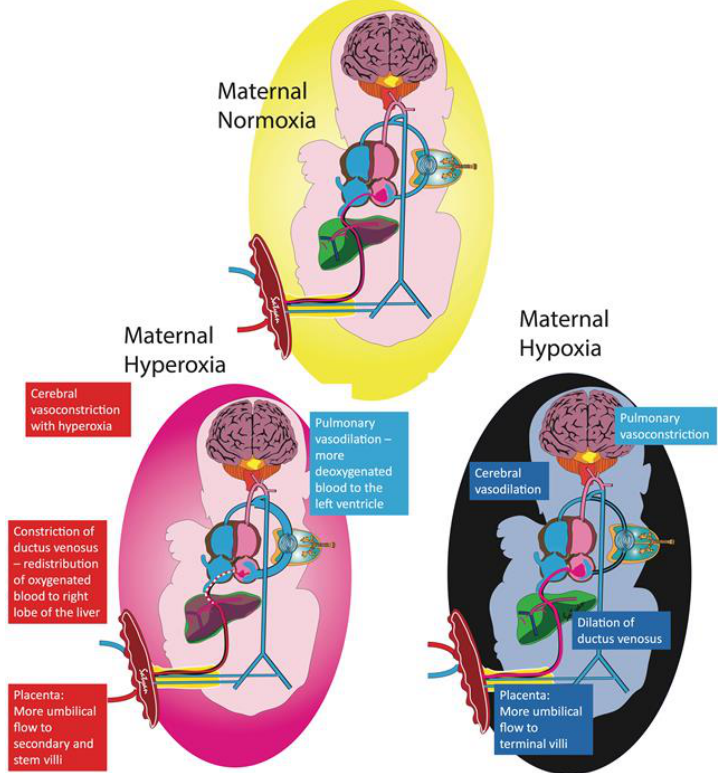
Figure 2. Fetal adaptation to maternal hypoxia and hyperoxia. The pulmonary circulation plays an